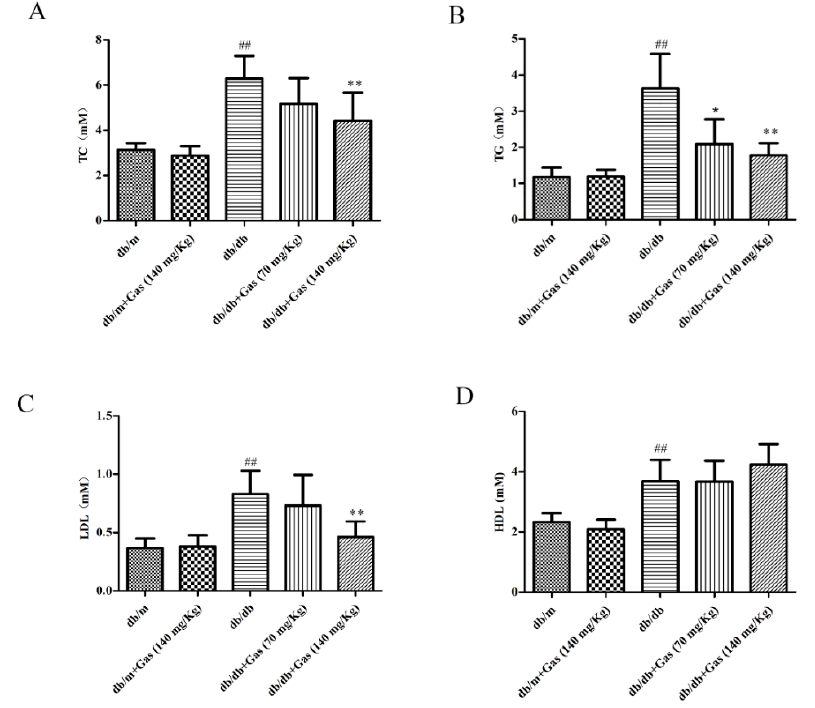
Figure 5. Gas improves dyslipidemia in db/db mice. ( A ) Levels of total cholesterol (TC) in plasma samples of mice after 12 weeks of treatment. ( B ) Levels of triglyceride (TG) in plasma samples of mice after 12 weeks of treatment. ( C ) Levels of low-density lipoprotein cholesterol (LDL-C) in plasma samples of mice after 12 weeks of treatment. ( D ) Levels of high-density lipoprotein cholesterol (HDL-C) in plasma samples of mice after 12 weeks of treatment. Values are represented as means ± SD for 10 mice in each group. ## p < 0.01, compared with the db/m group. * p < 0.05, ** p < 0.01, compared with the db/db group.